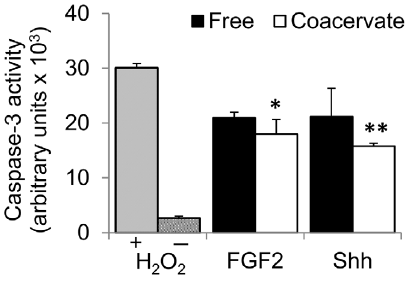
Figure 4. Cytoprotection of cardiomyocytes from oxidative stress-induced apoptosis. Myocytes were pre-treated for 48 h with FGF2 or Shh, free or delivered in the coacervate. Cells were then exposed to oxidative stress conditions with H 2 O 2 for 2 h. Two control groups were not pre-treated with any growth factors and then one received H 2 O 2 for 2 h ( + ) and one did not ( 2 ). Cell apoptosis levels were measured by caspase-3 activity. * P , 0.05, ** P , 0.01 compared to the +